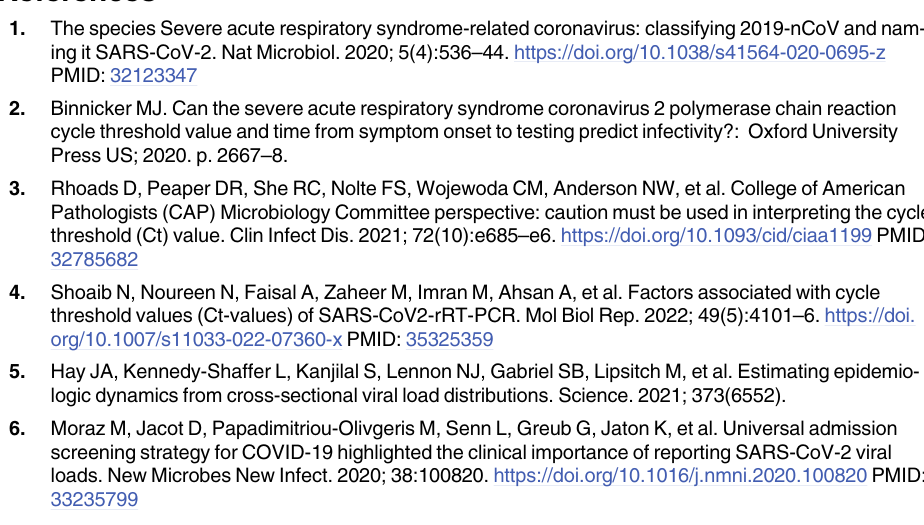
S1 Fig. Pearson correlation between observed data and forecasted values. (a) Correlation between actual cases and cases predicted using the model generated with overall Ct values for all cases. (r = 0.789, p < 0.05). (b) Correlation between actual cases and cases predicted using the model generated with Ct values for asymptomatic cases. (r = 0.879, p < 0.05). S1 Table. Number of SARS-CoV-2 positive individuals and the total tests performed in each month. S2 Table. 95% Confidence Interval of the monthly Ct values. (DOCX) S1 Dataset. Minimal data set for the current